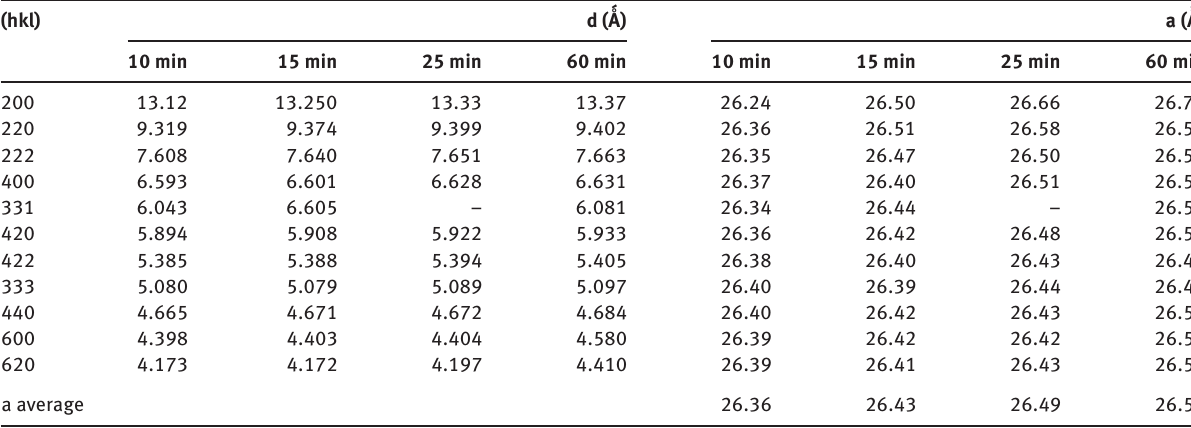
Table 5: (hkl), distance between crystal planes d and lattice parameter (a) of Cu-BTC, formed from Cu and benzene-1,3,5-tricarboxylic acid, synthesized with different electrodeposition